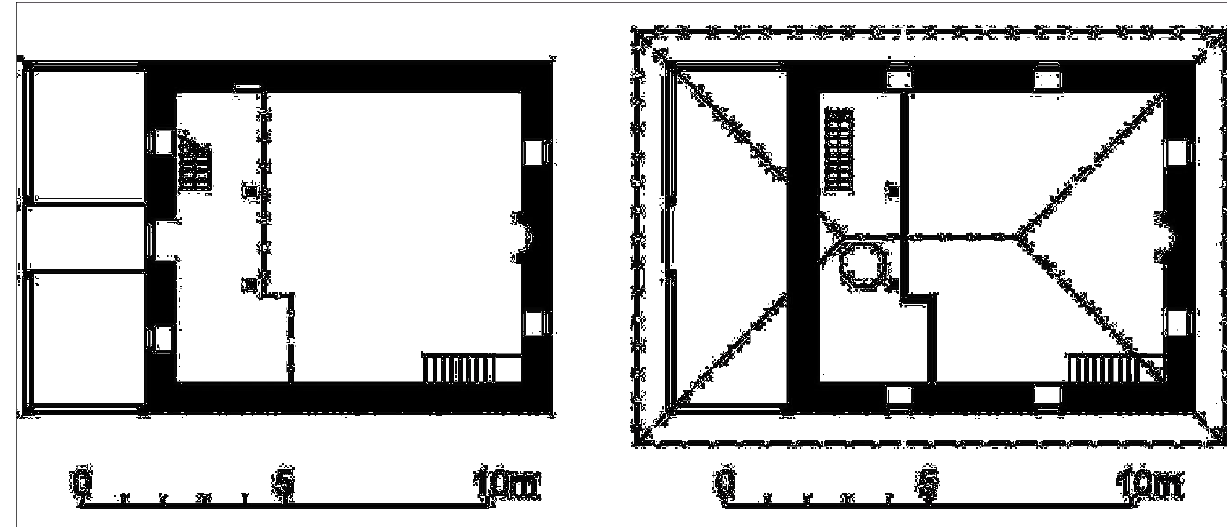
Figure 2. Floor Plans of Osman Ćehaja Mosque in Tuzla: Ground Floor (left), Mahfil (right) (drawings by the author)